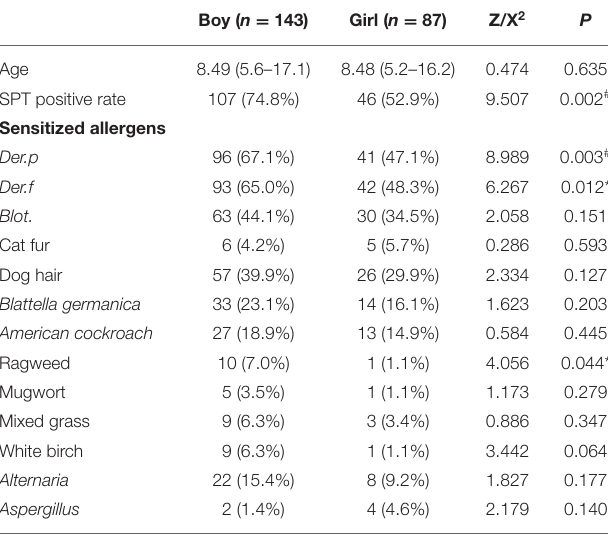
TABLE 2 | Comparison of sensitized allergens between different genders. Boy ( n =